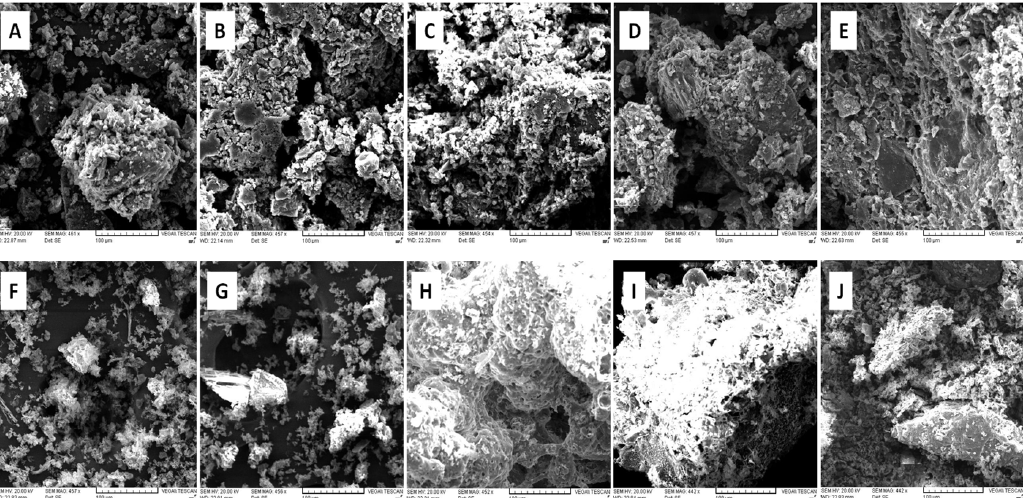
Figure 11. SEM images of coal ( A ), Coalgae ® 5% ( B ), Coalgae ® 10% ( C ), Coalgae ® 15% ( D ), and Coal- gae ® 20% ( E ) and ash residues of coal ( F ), Coalgae ® 5% ( G ), Coalgae ® 10% ( H ), Coalgae ® 15% ( I ), and Coalgae ® 20% ( J